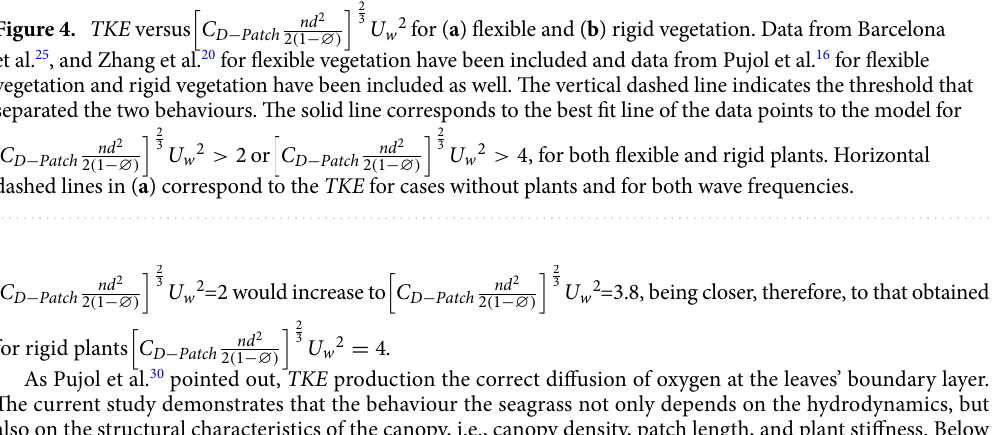
2 3 U 2 for ( a ) flexible and ( b ) rigid vegetation. Data from Barcelona w 2 3 U 2 > 4 , for both flexible and rigid plants. Horizontal w